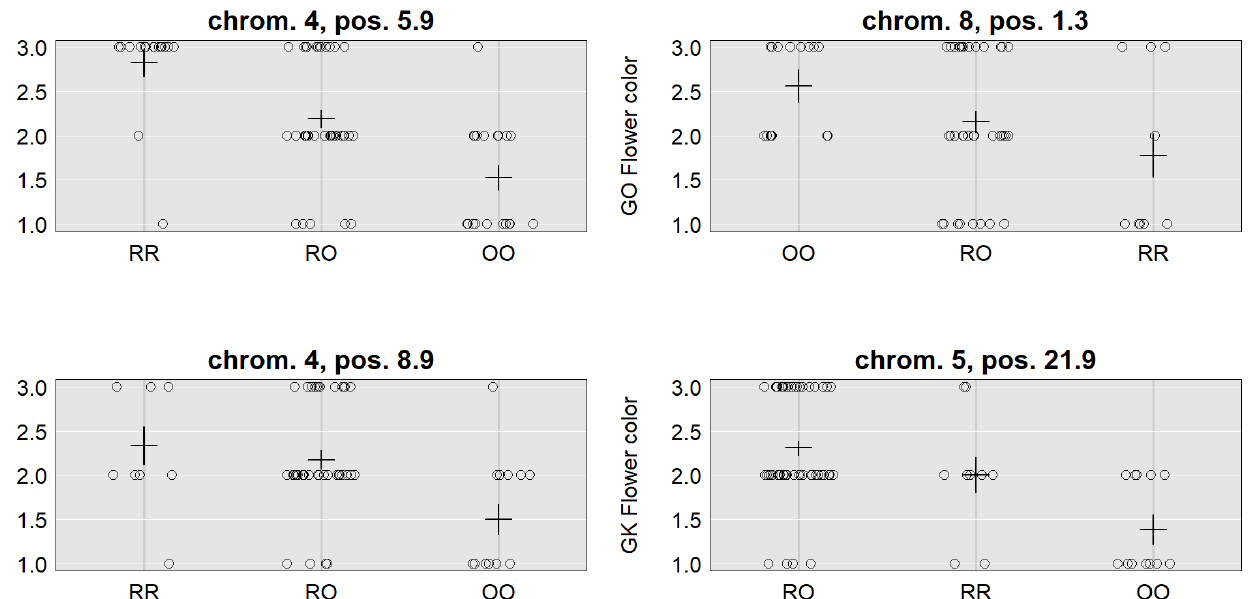
Figure 5. Frequency distribution of flower color in ten chickpea NAM populations. The het category means heterozygous mix of white and purple flowers. Bar heights are proportions and values above bars are counts.